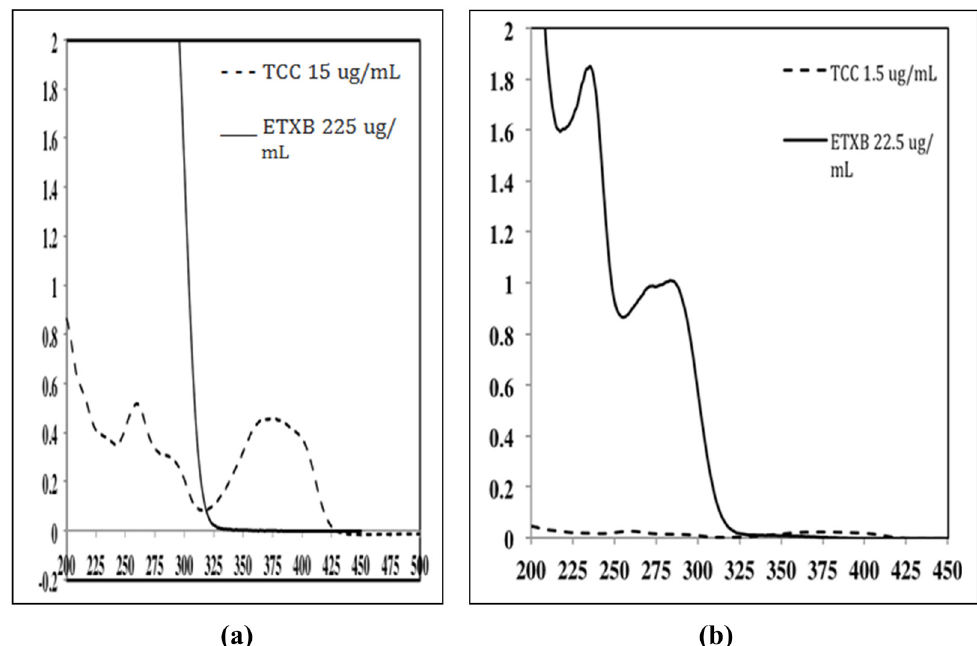
Figure 3: UV - absorption spectra of ( a ) 15 μ g · mL − 1 TCC ( dashed line ) and 225 μ g · mL − 1 ETXB ( black line ) in distilled water, and ( b ) 1.5 μ g · mL − 1 TCC ( dashed line ) and 22.5 μ g · mL − 1 ETXB ( black line ) in distilled